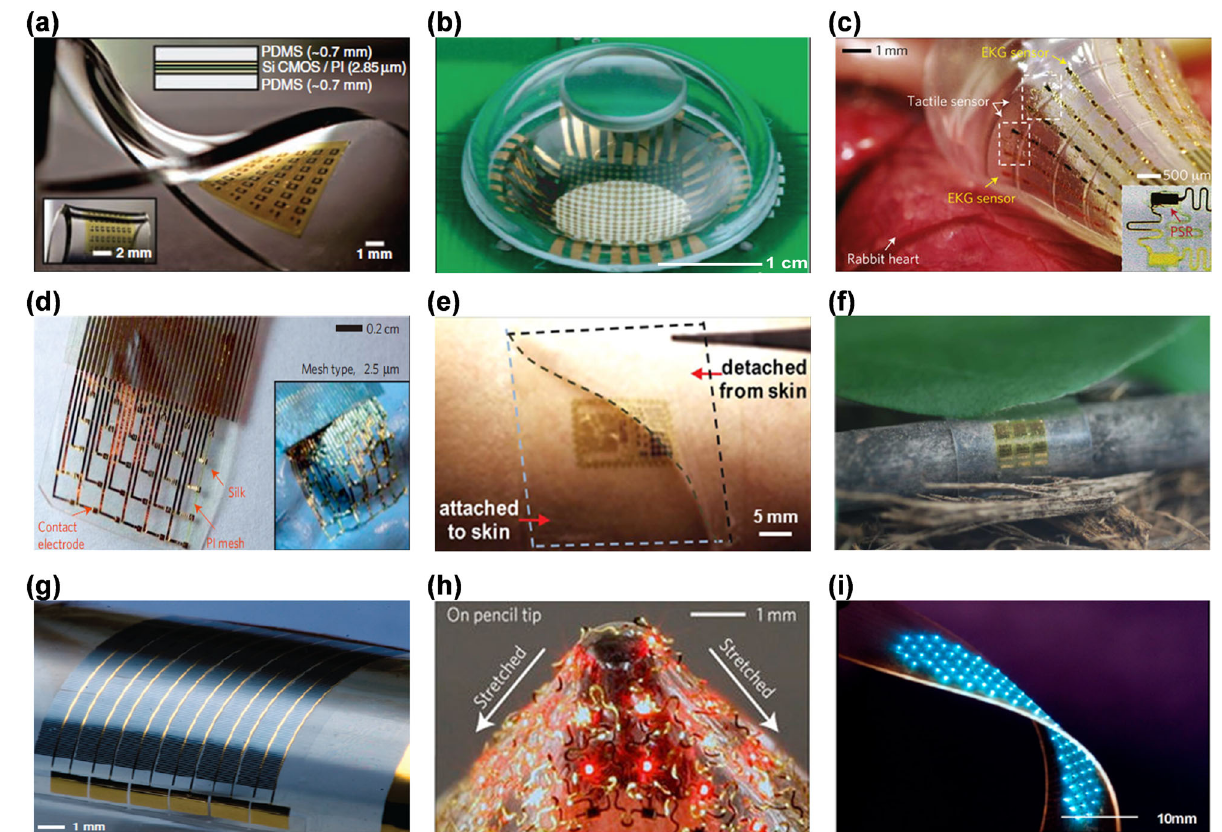
Fig. 1 Flexible and stretchable inorganic electronic devices enabled by transfer printing techniques. a Stretchable and foldable Si-CMOS circuit transferred onto a poly(dimethylsiloxane) (PDMS) substrate. Reprinted with permissions from ref. 28 . b A hemispherical electronic eye camera based on compressible silicon optoelectronics. The silicon optoelectronics are transferred from a fl at donor substrate and printed onto a hemispherical glass lens substrate using a hemispherical PDMS transfer element. Reprinted with permissions from ref. 6 . c Multifunctional balloon catheters with biocompatible interfaces integrated directly by transfer printing for cardiac electrophysiological mapping and ablation therapy in its in fl ated state. Reprinted with permissions from ref. 9 . d Ultrathin conformal bio-integrated neural electrode arrays transfer- printed onto a dissolvable silk substrate. Reprinted with permissions from ref. 29 . e Multifunctional epidermal electronic systems partially peeled away from the skin. Reprinted with permissions from ref. 14 . f A photograph of an array of GaInP/GaAs heterojunction bipolar transistors transfer-printed onto a biodegradable cellulose nano fi bril substrate and wrapped around a tree stick with a ~3 mm radius. Reprinted with permissions from ref. 16 g A bendable photovoltaics module that use large-scale arrays of silicon solar microcells created from bulk wafers and integrated in sparse spatial layouts on foreign substrates by transfer printing. Reprinted with permissions from ref. 23 h Optical images of an array of AlInGaP μ -ILEDs (6 × 6) transferred onto a PDMS substrate and tightly stretched on the sharp tip of a pencil. Reprinted with permissions from ref. 30 i Image of a mechanically fl exed array of ultrathin, microscale, blue LEDs printed from a source wafer onto a thin strip of plastic. Reprinted with permissions from ref.